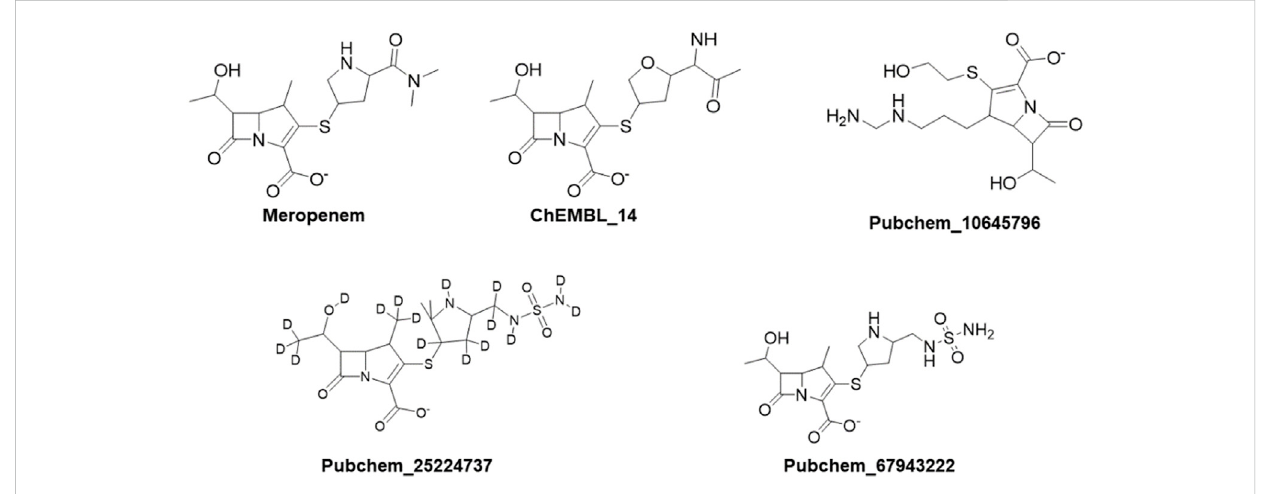
FIGURE 1 Resulting compounds from Glide-XP screening taken for covalent docking analysis.